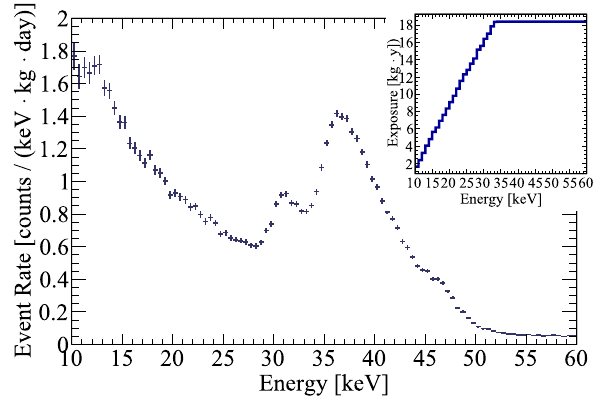
Fig. 5 Efficiency-corrected energy spectrum of CUORE-0 from 10 to 60keVcorrespondingtoanexposurerangingfrom1 . 6kgyear at10keV up to 18 . 56kgyear at 35keV, as shown in the inset